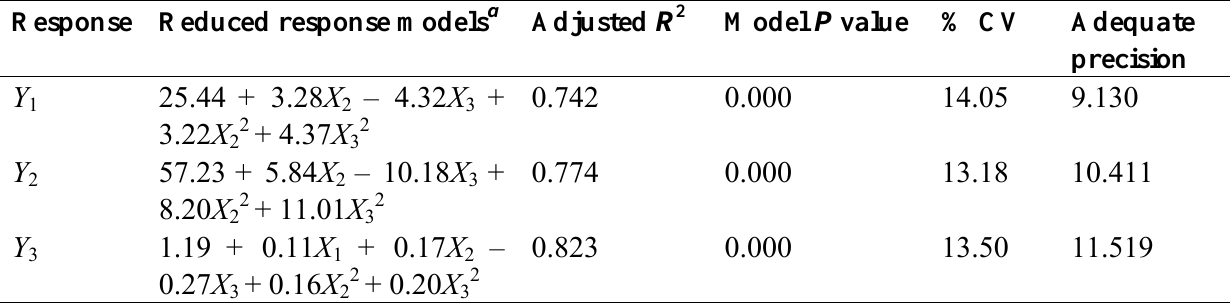
Table 3. Reduced response models and statistical parameters obtained from ANOVA (after backward